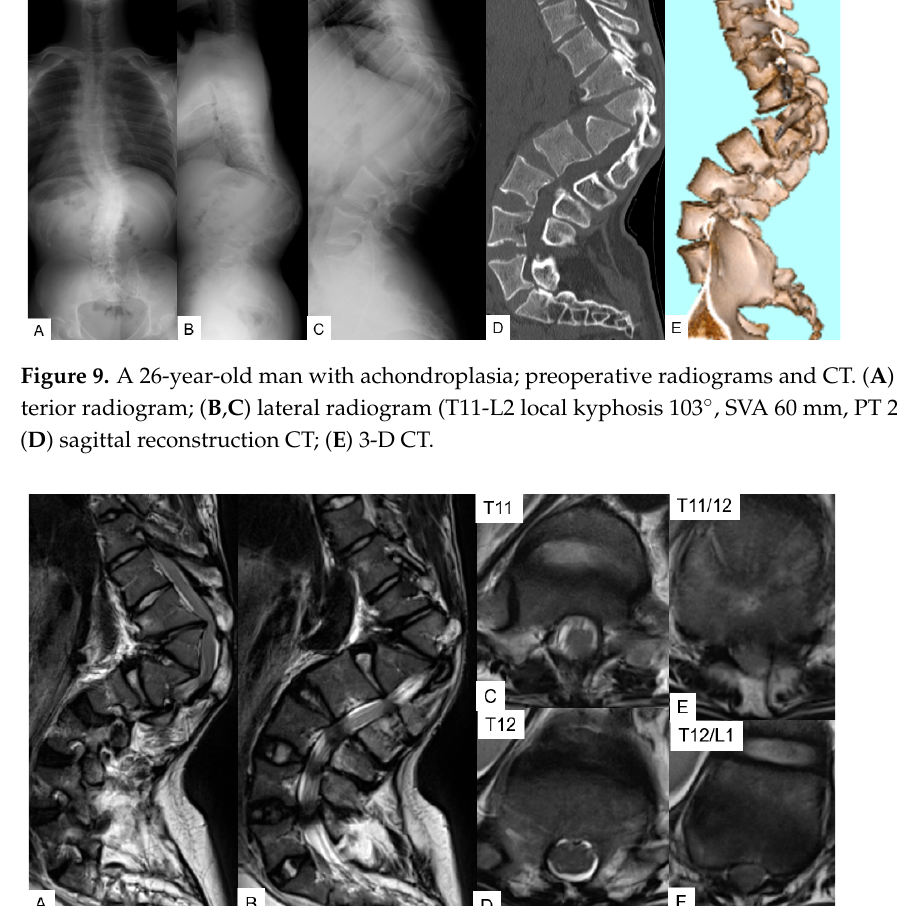
Figure 10. A 26-year-old man with achondroplasia; preoperative MRI. ( A , B ) Thoracolumbar sagittal T2-weighted MR imaging; ( C – F ) axial T2-weighted MR images show severe stenosis at the T11/12 and L1/2 level.